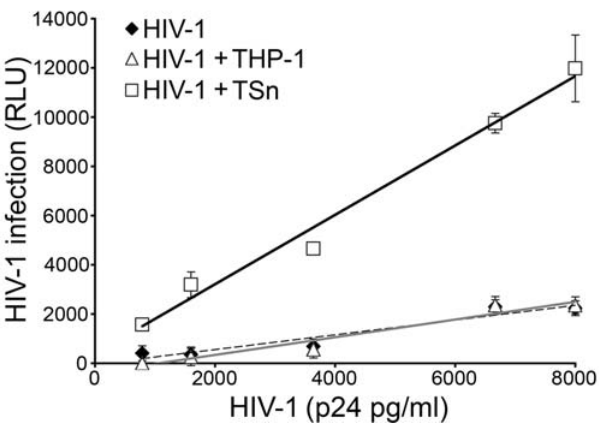
Figure 6. Sn-expressing cells capture HIV-1 NL4-3 and enhance infectivity. TZM-bl cell cultures were seeded with various concentra- tions of HIV-1 NL4-3 (800–8000 pg/ml). Monocytic cells, TSn or THP-1 cells, were added and cocultured for 48 h. The capacity of Sn to capture HIV-1 NL4-3 in the cell culture medium and trans infect TZM-bl cells was analyzed for TSn, THP-1 and cell-free virus. Luciferase expression in HIV- 1 NL4-3 -infected TZM-bl cells was quantified as relative light units (RLU). Results were compiled from 3 separate experiments. Error bars represent SD.